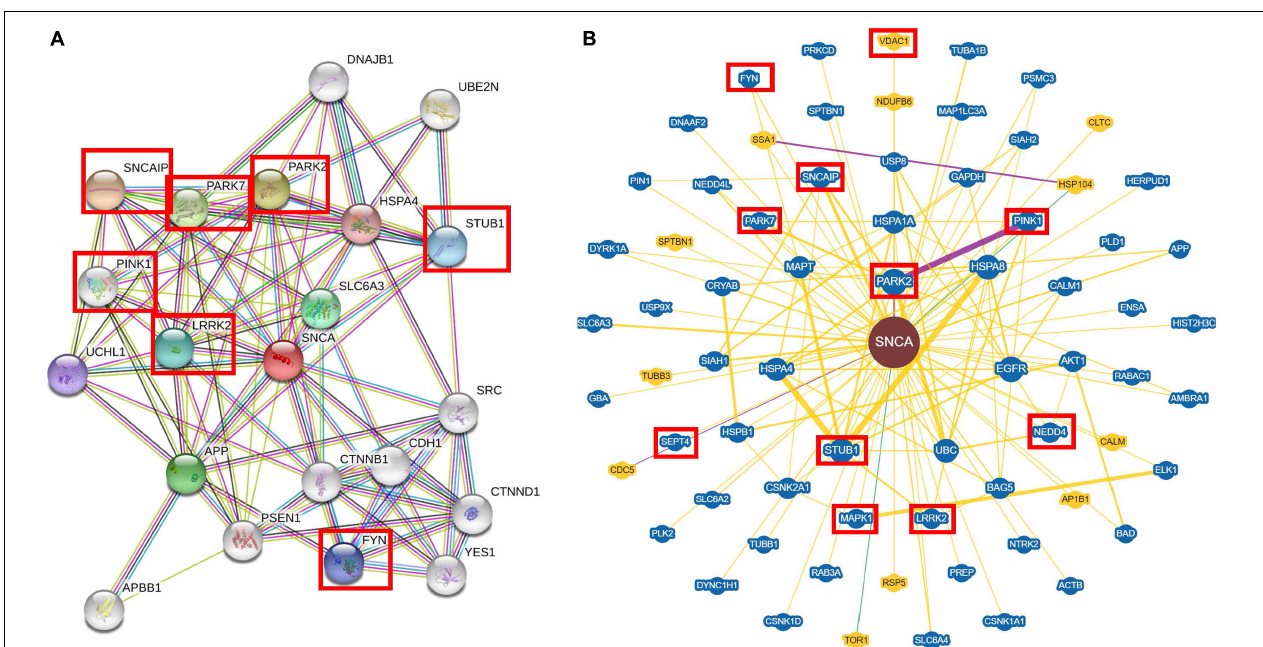
FIGURE 1 | Interaction of the alpha-synuclein with soluble proteins by STRING and BioGRID 3 . 5 . (A) STRING and (B) BioGRID 3 . 5 show that alpha-synuclein ( α -syn) interacts mostly with kinase proteins like LRKK2, MAPK1, Fyn, etc. and it can interact with ubiquitin proteins like PARK2, PARK7, STUB1, etc. Each interactor is shown as a circle and the lines represent the interaction between the proteins. The interactors in a red box are mentioned in the interaction section and also throughout the